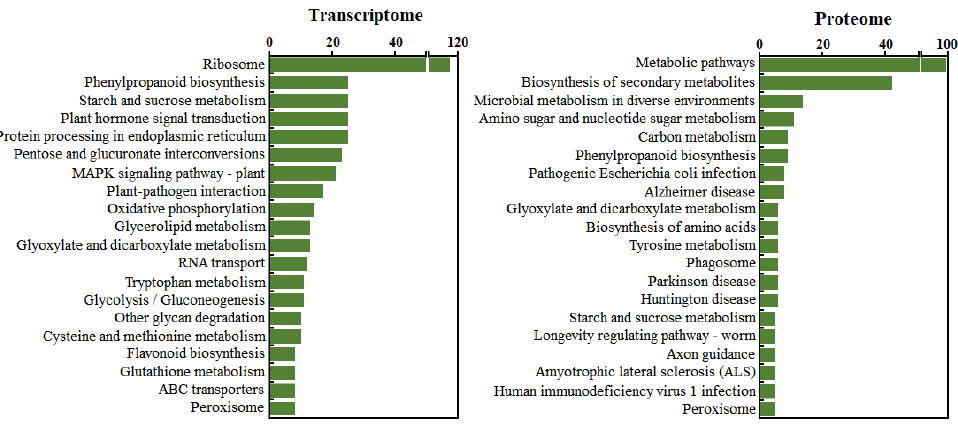
Figure 5. KEGG pathway analyses of the differentially expressed genes and proteins.